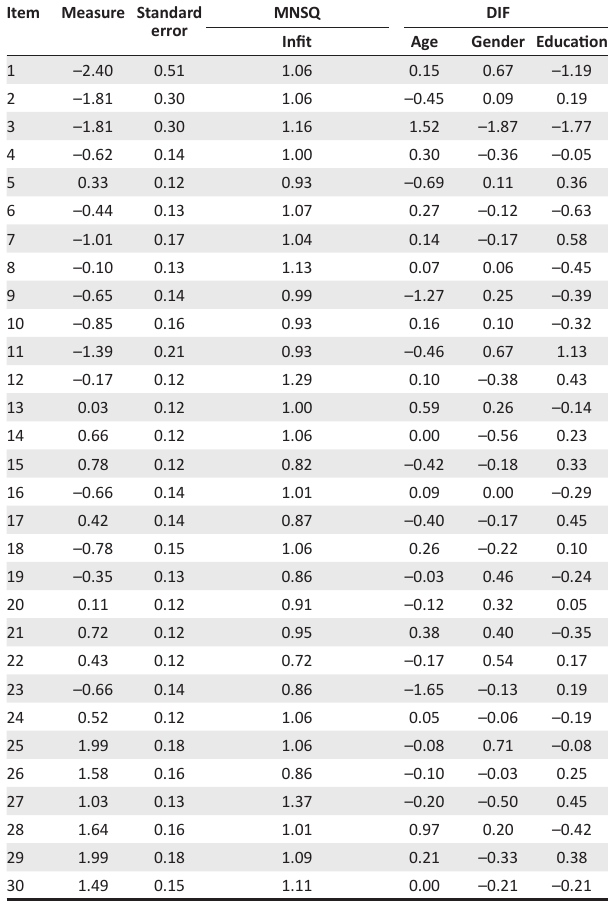
TABLE 3: Rasch fit and Differential Item Functioning